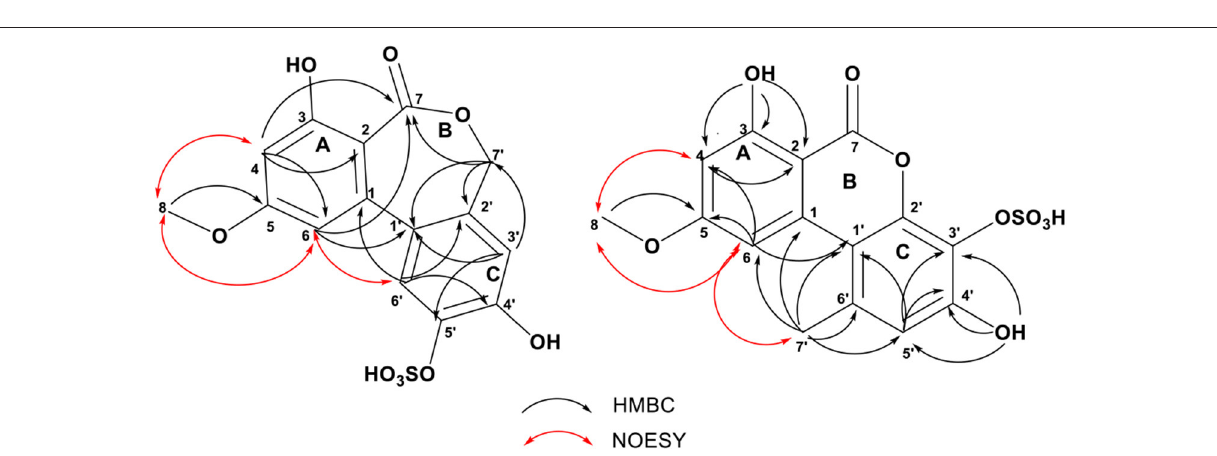
FIGURE 3 | Selected HMBC and NOESY correlations of compounds 1 and 2